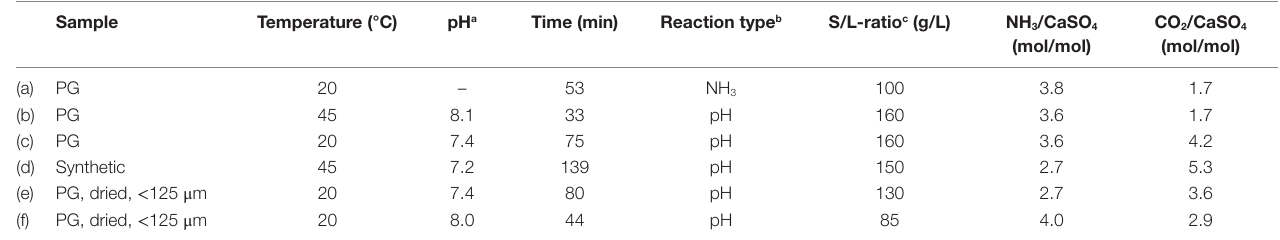
TaBle 2 | The performed cacO 3 precipitation experiments (a)–(f).